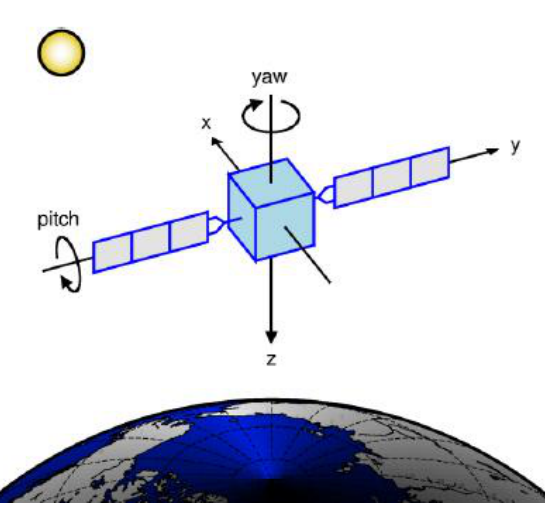
Figure 1: Satellite’s nominal yaw attitude and its constraints.